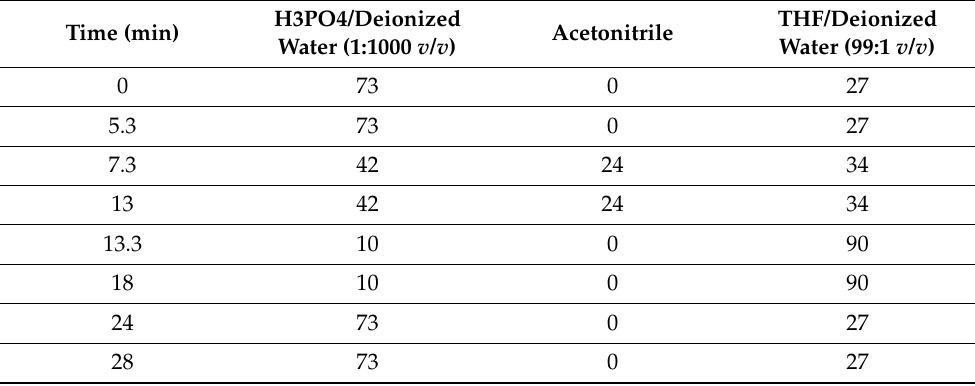
Table 1. Elution gradient for the separation of skatole and androstenone on an High-Performance Liquid Chromatography Fluorescence Detection (HPLC)